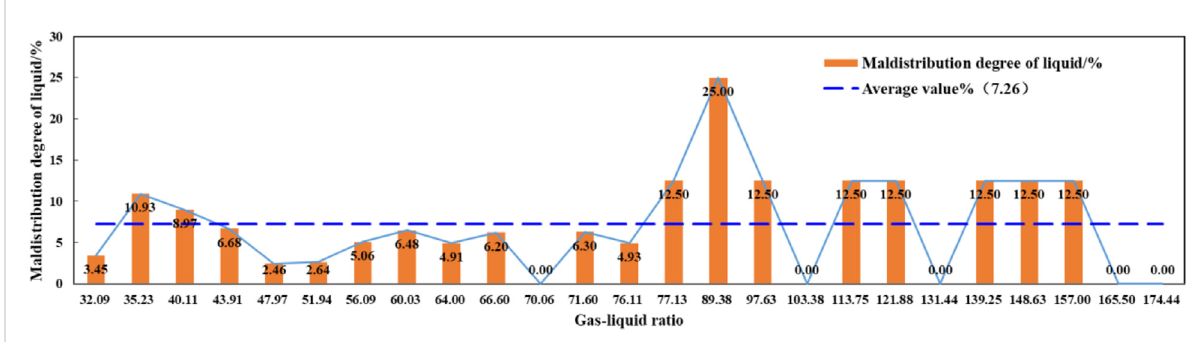
FIGURE 12 Histogram of gas – liquid ratio and maldistribution degree of liquid in annular fl ow in horizontal manifold without fl ute pipes (liquid injection volume 0.16L/s+0.35L/s).